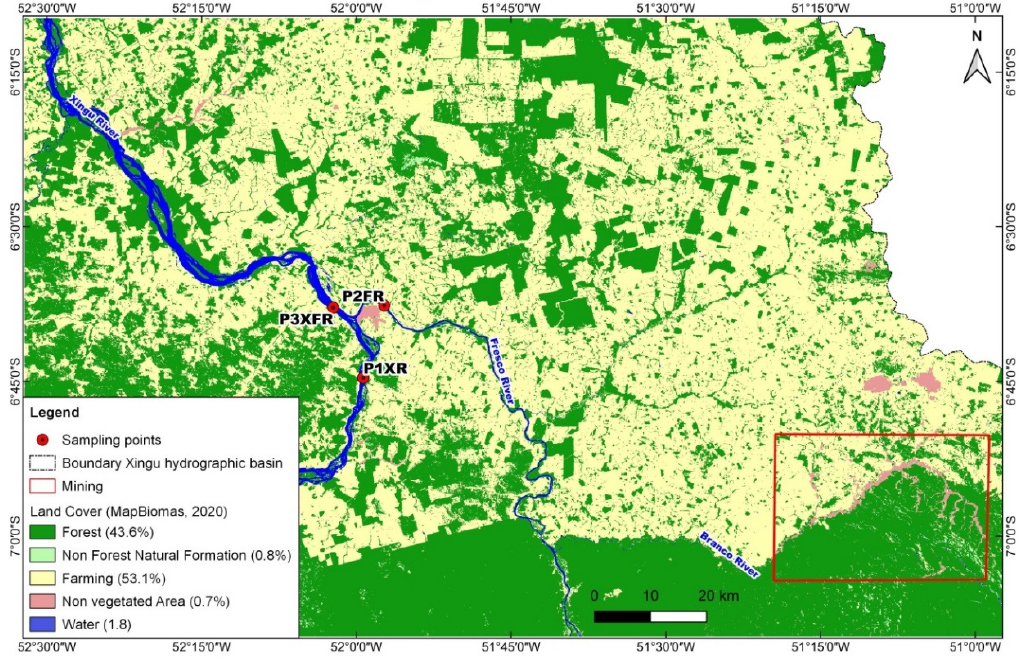
Figure 2. Map showing the spatial distribution of land use classes and vegetation cover in the study area in the municipality of São Félix do Xingu, Pará state, Brazil. The red rectangle in the lower right-hand corner indicates an extensive mining area near the Branco River, a tributary of the Fresco